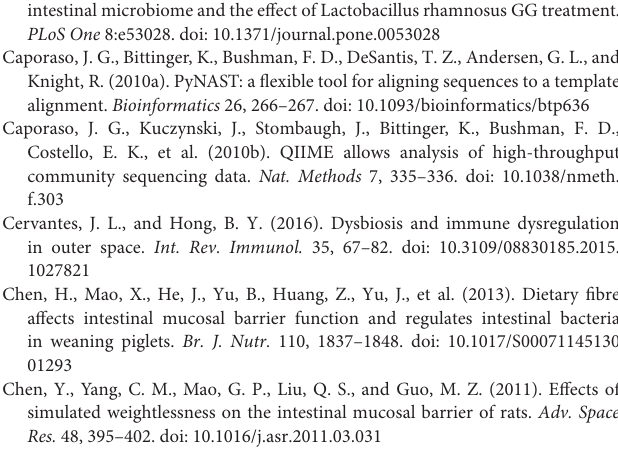
FIGURE S2 | Expression pattern of claudin-1 and E-cadherin in ileum by immunohistochemistry assay. CON, control group; SUS, simulated weightlessness